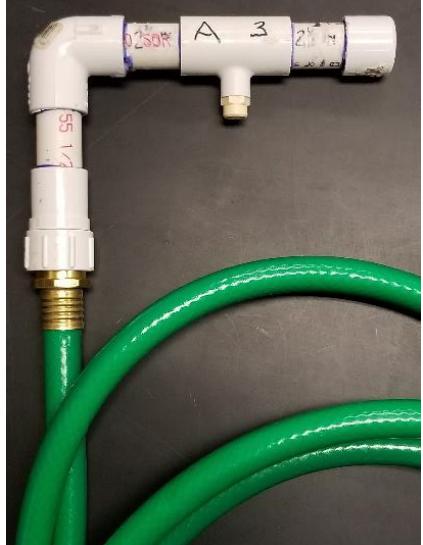
Figure 6. The constructed soil column mister nozzle and piping. Environments 2019 , 6 , x FOR PEER REVIEW